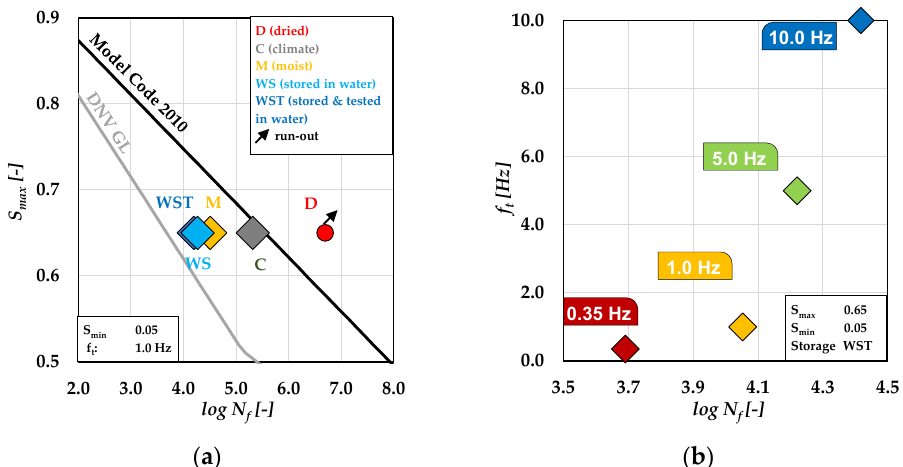
Figure 2. Numbers of cycles to failure depending on the storage condition ( a ) [22]; depending on the load frequency for storage condition WST ( b ).